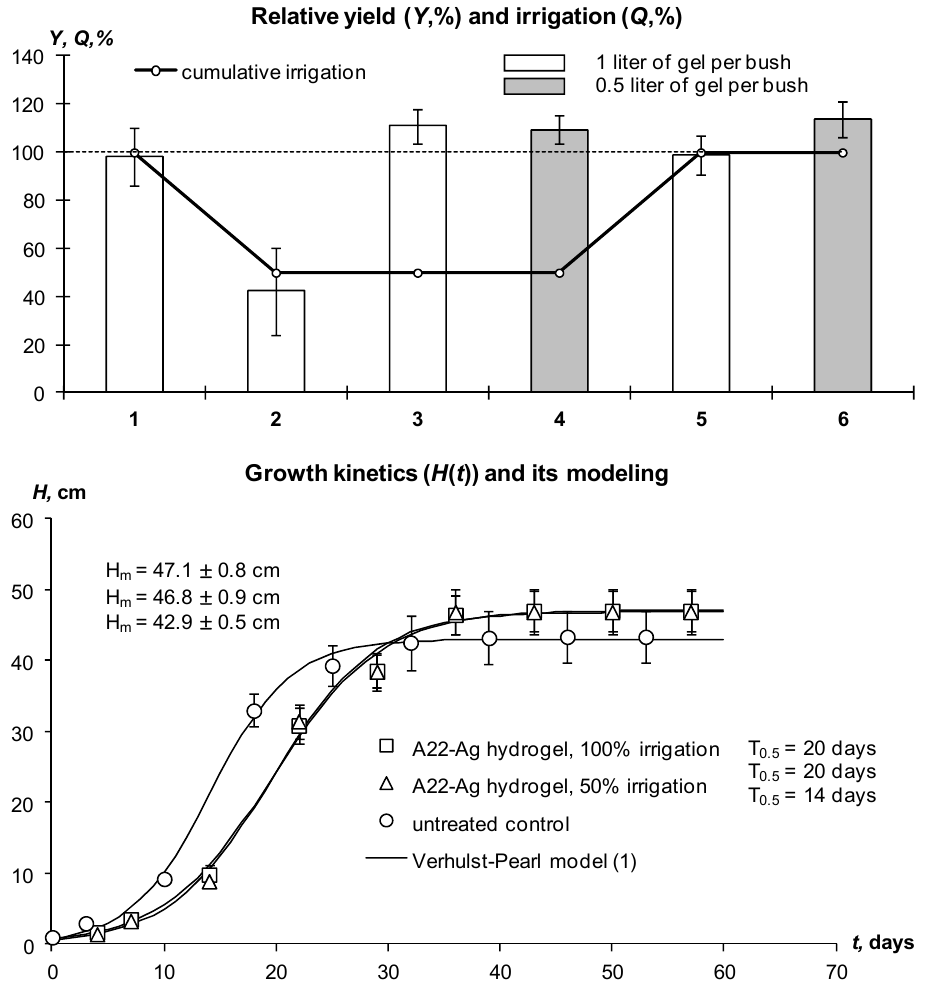
Figure 8. Yield and growth rate for the Gala potato variety under the influence of irrigation and gel-forming soil conditioners (Uzbekistan, Serozem, furrow irrigation, 2018): 1, 2—untreated control, 100 and 50% irrigation norm (400 mm); 3, 4—A22-Ag hydrogel, 50% irrigation; 5—A11 hydrogel, 100% irrigation; 6—A22-Ag hydrogel, 100% irrigation. The dotted line (100%) is the potential yield of 40 t/ha.